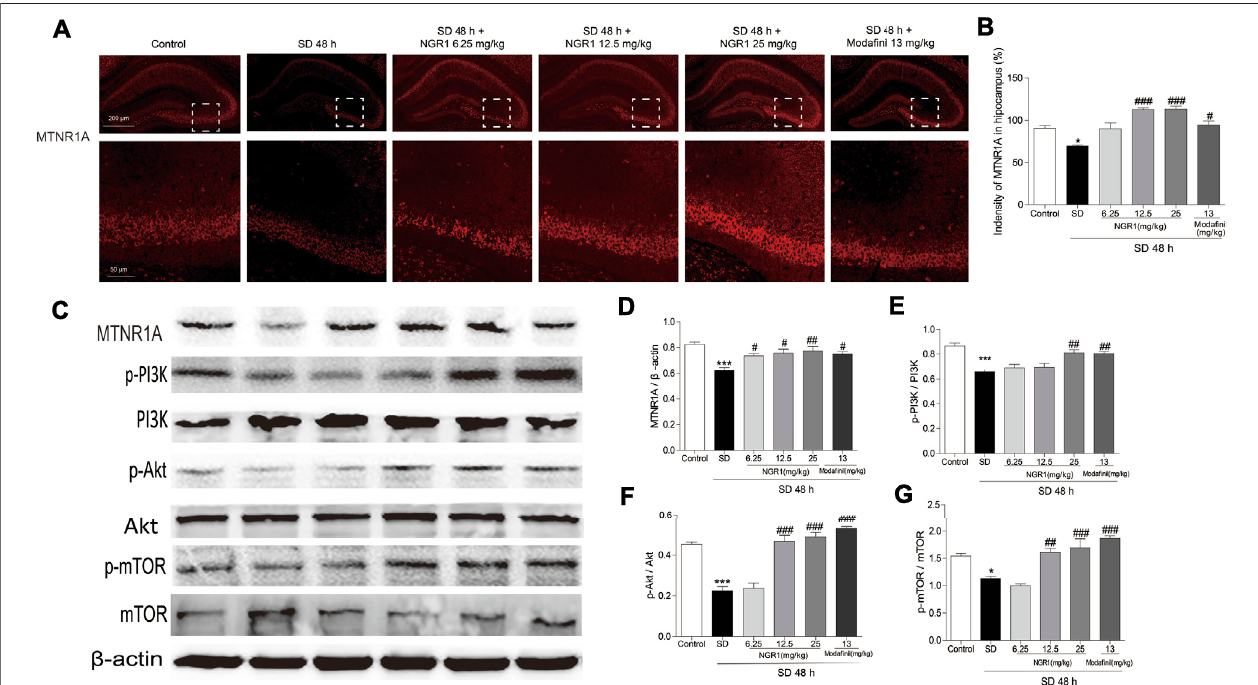
FIGURE3| NGR1resumedthedecreasedMTNR1AinthehippocampusinducedbySD. (A) ImmunostainingofMTNR1Ainthehippocampus.Scalebar:200and 50 µm. (B) Comparison of immuno fl uorescence intensity of MTNR1A in the hippocampus. n (cid:1) 3/group. (C) Protein expression of MTNR1A in hippocampi. n (cid:1) 5/group. (D – G) Proteinexpressions ofthephosphorylatedPI3K, Akt,and mTORinhippocampi.n (cid:1) 5/group.* p < 0.05; *** p < 0.001vs.controlgroup.## p < 0.01, ### p < 0.001 vs. SD group. (NGR1: notoginsenoside R1; MTNR1A: melatonin receptors 1A; SD: sleep deprivation; mTOR, mammalian target of rapamycin; p-Akt, phosphorylated PKB; p-PI3K, phosphorylated